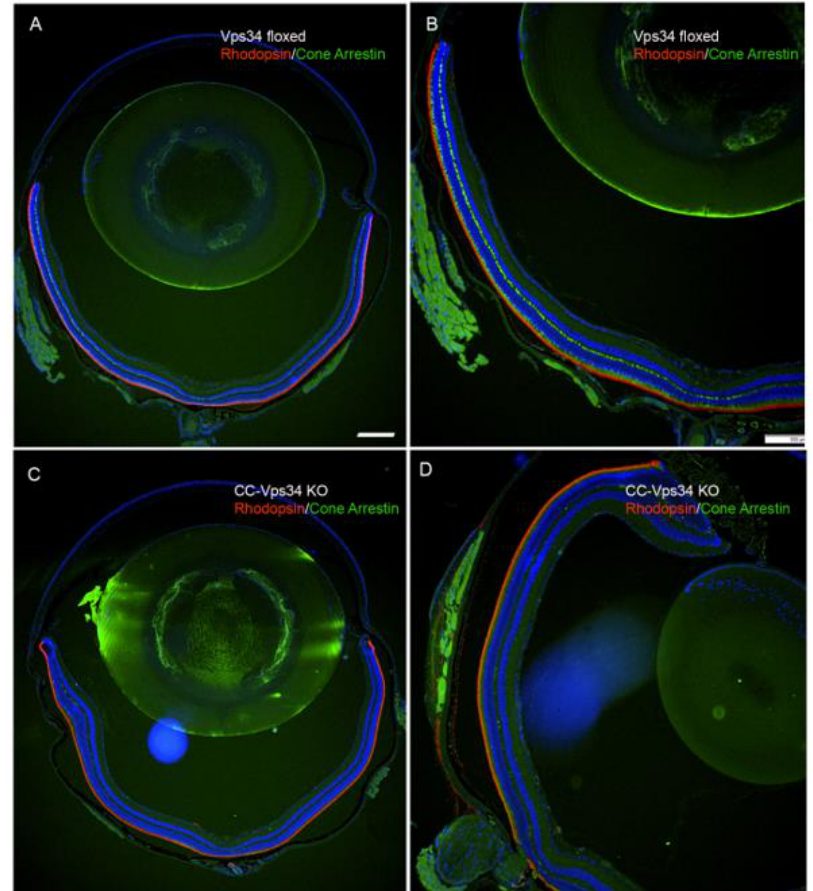
Figure 6. The loss of Vps34 in cones did not affect rod structure. Prefer-fixed sections of 6-week-old Vps34-floxed and CC-Vps34 KO mouse retinas were subjected to immunofluorescence with anti-rhodopsin (red) and anti-cone arrestin (green) antibodies. Images were captured from dorsal and ventral regions of the retina ( A , C ). The dorsal region of the retina was captured at higher magnification ( B , D ). Scale bar = 100 μm.